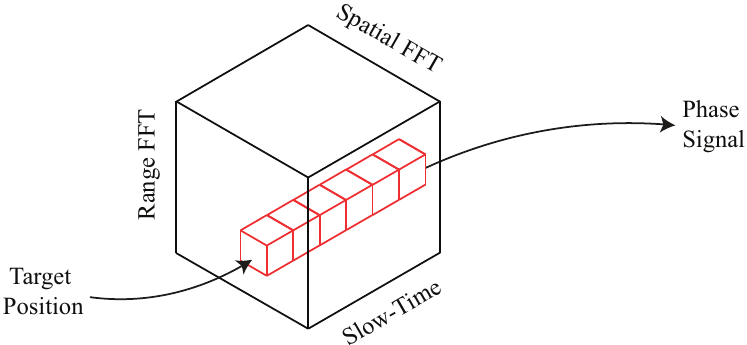
Figure 10. Radar signal processing